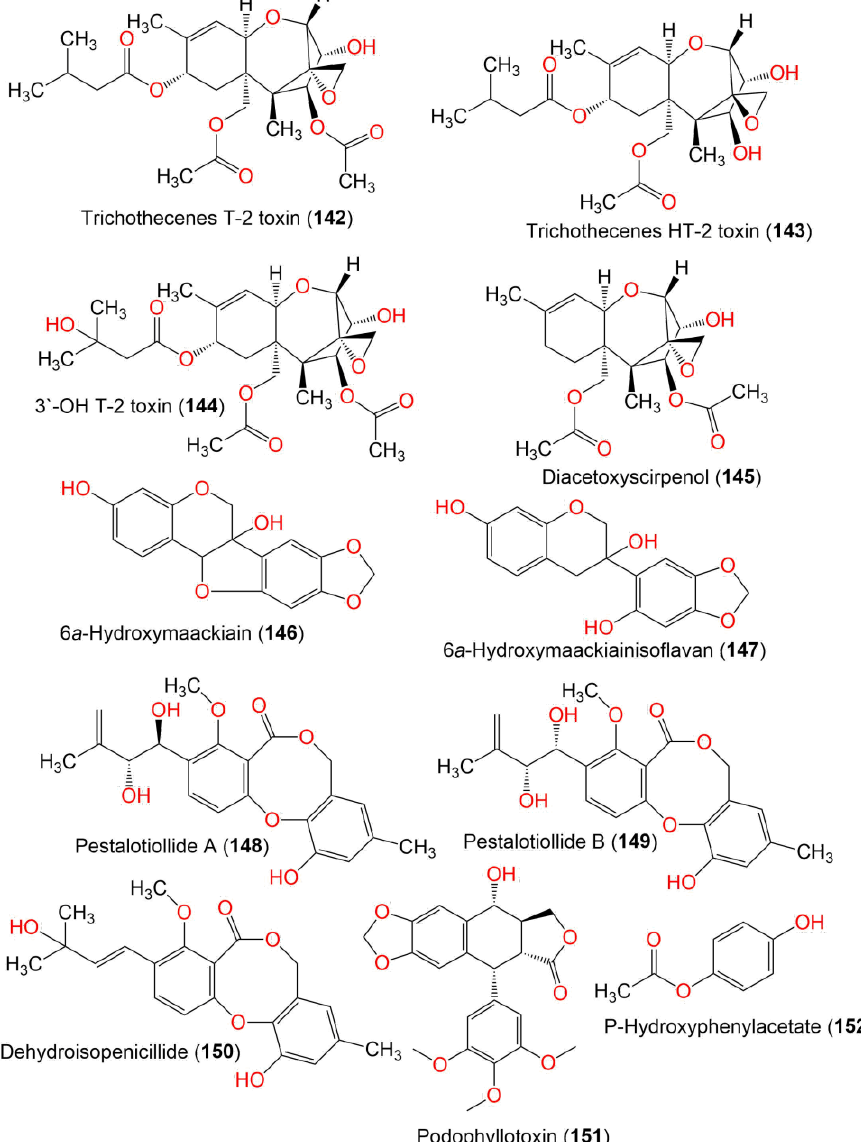
Figure 16. Structures of terpenoids ( 142 – 145 ), flavonoids ( 146 and 147 ), depsidones ( 148 – 150 ), lignan ( 151 ), and phenolic compound ( 152 ).